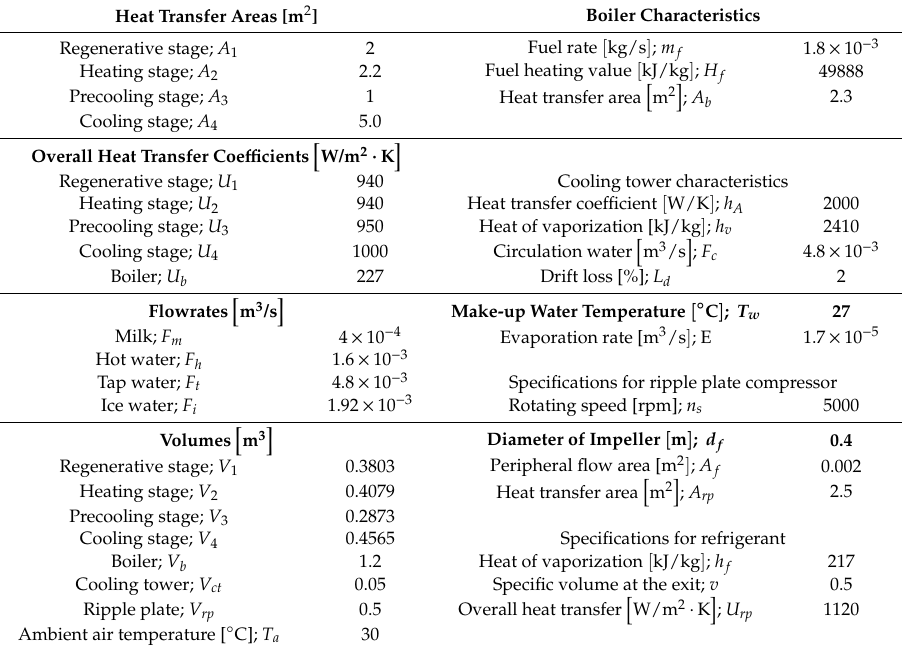
Table 1. Physical properties and process data for the